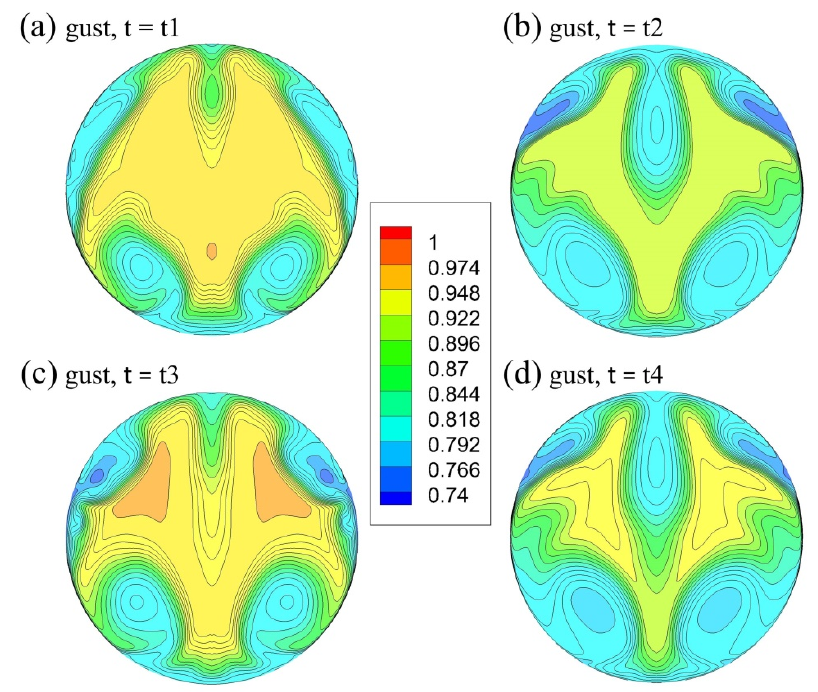
Figure 22. Total pressure contours at the AIP at four instances of the gust case of f = 100 Hz and (cid:101) u g = 8 m/s.